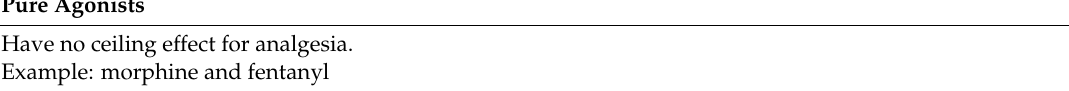
Table 2. Categories of opioid receptor